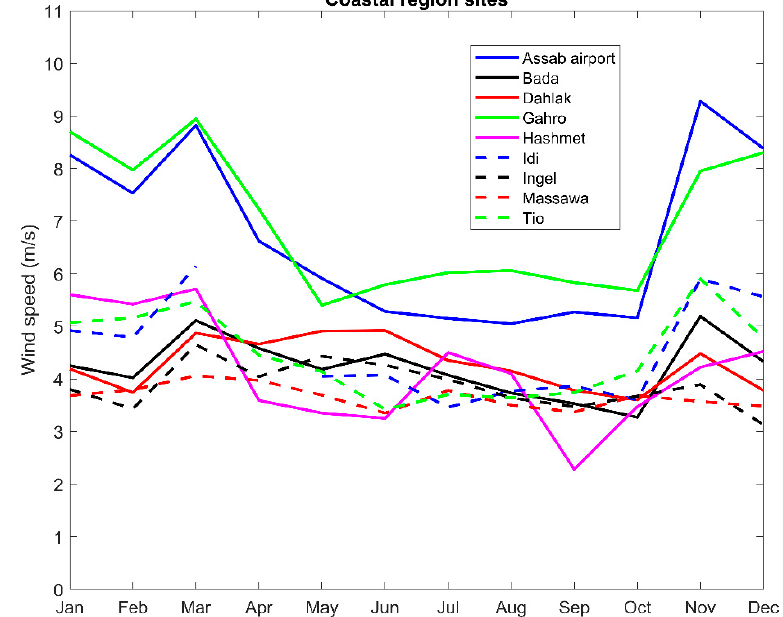
Figure 4. Mean wind speed per month for the year 2000 for the coastal region sites. Note that the April mean value is missing for Idi (12 days of data are missing).